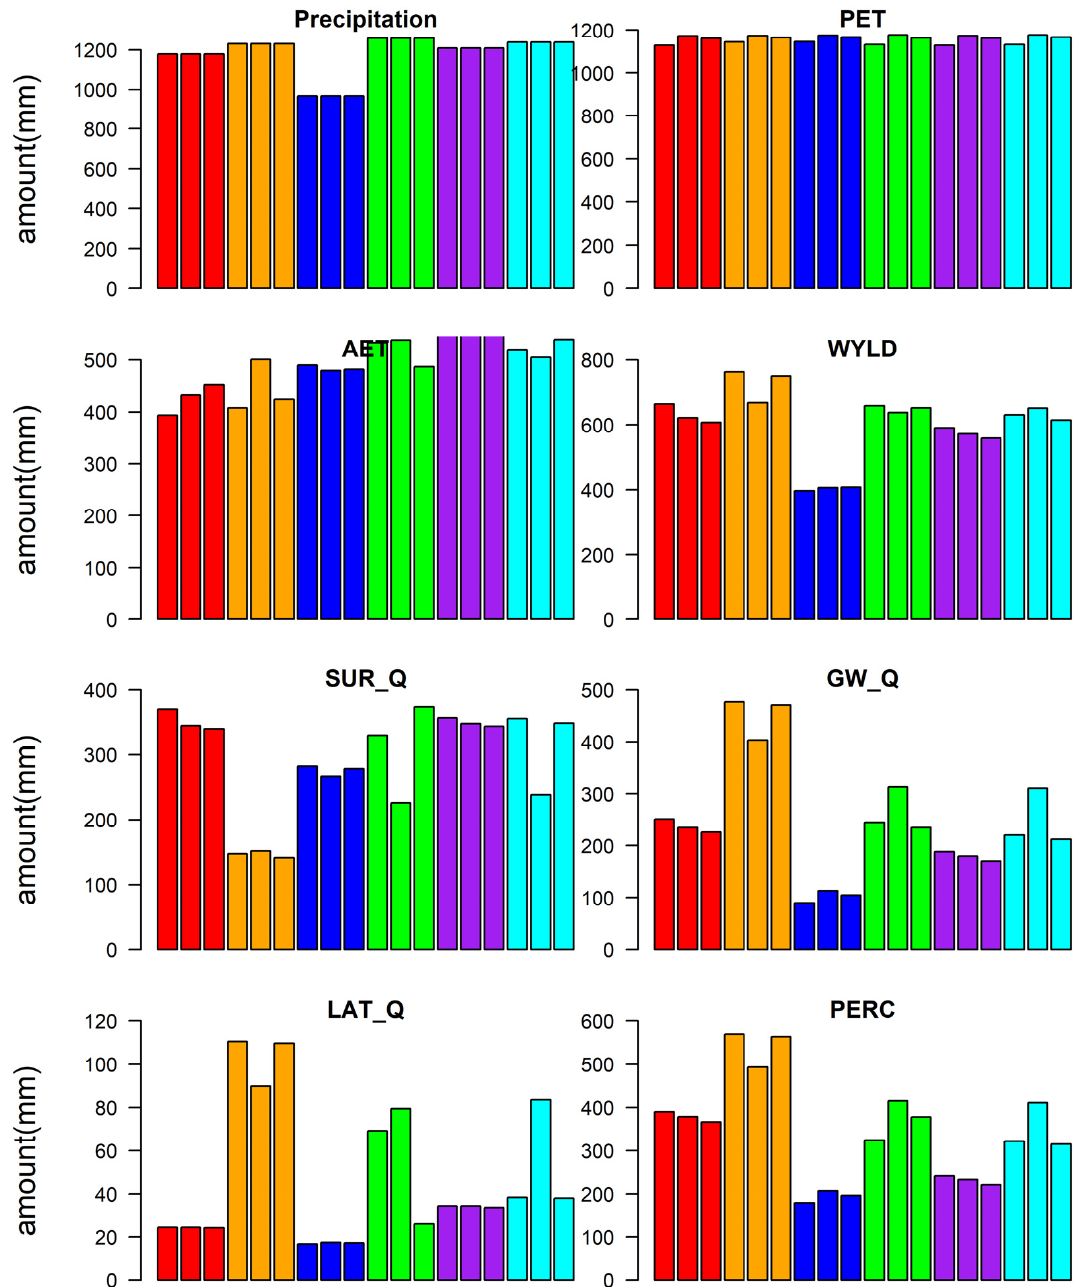
Figure 9. Annual mean water balance components for simulations using eighteen scenarios during 2009–2014. The different colors represent using different precipitation datasets (a—Gauge; b— CFSR; c—CMADS; d—TRMM; e—CMORPH; f—CHIRPS), and the three bars displayed in the same color used the Gauge, CFSR, and CMADS meteorological data from left to right, respectively. AET— actual evapotranspiration; WYLD—water yield, the net amount of water that leaves the subbasin and contributes to streamflow in the reach; SUR_Q—surface runoff contribution to streamflow; GW_Q—groundwater contribution to streamflow; LAT_Q—lateral flow contribution to stream- flow; PERC—water percolating past the root zone.